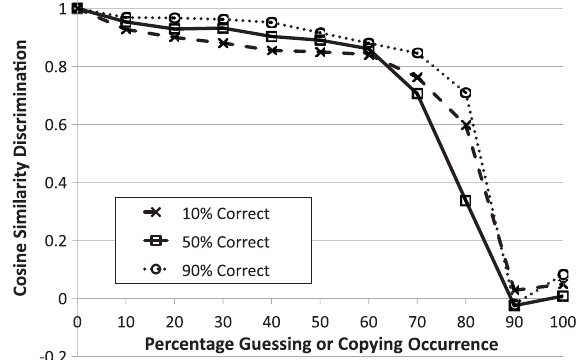
FIG. 9. Cosine similarity of the item discriminations from the “ clean ” exam values as a function of simulated copy or guess occurrence. Values are shown for a success rate of 10% ( “ educated guessing ” ), 50%, and 90% ( “ copying ” ).